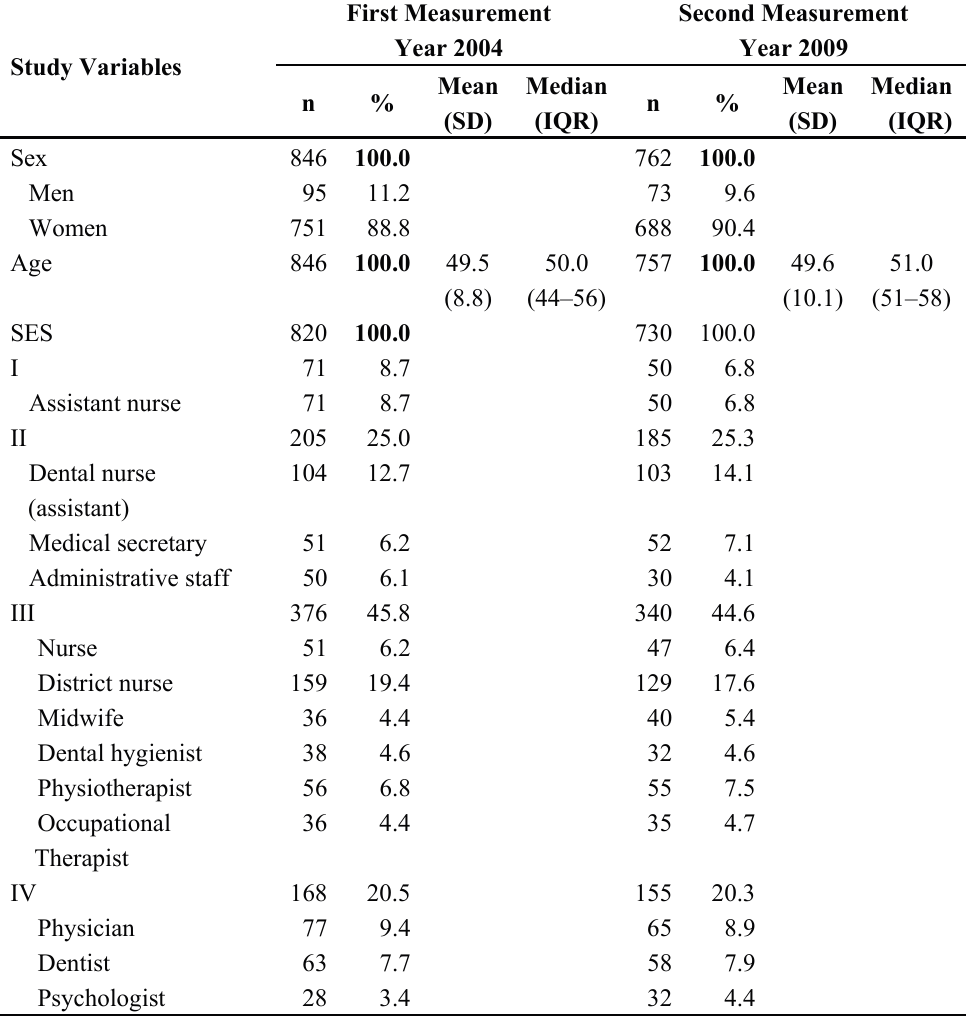
Table 1. Descriptive statistics pertaining to the distribution of background